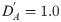
Dynamics of the average level of protein C (red), level of protein C at the front (green) and back (blue) for noise in the external chemoattractant gradient (top) and internal signaling pathway (bottom).Dotted lines are the average level of protein in the absence of any noise. Values used are β = 1.0, DA′=1.0, DB′=100.0 and η = 1.0 (top) and ν = 0.25 (below).